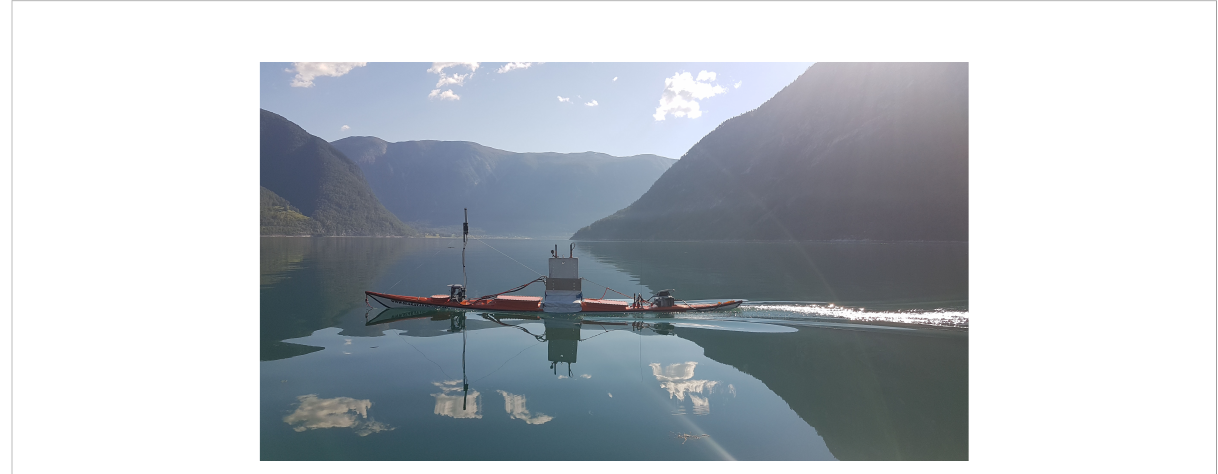
FIGURE 5 The Kayak Drone in operation during the sprat acoustic survey in Årdalsfjorden, Norway,